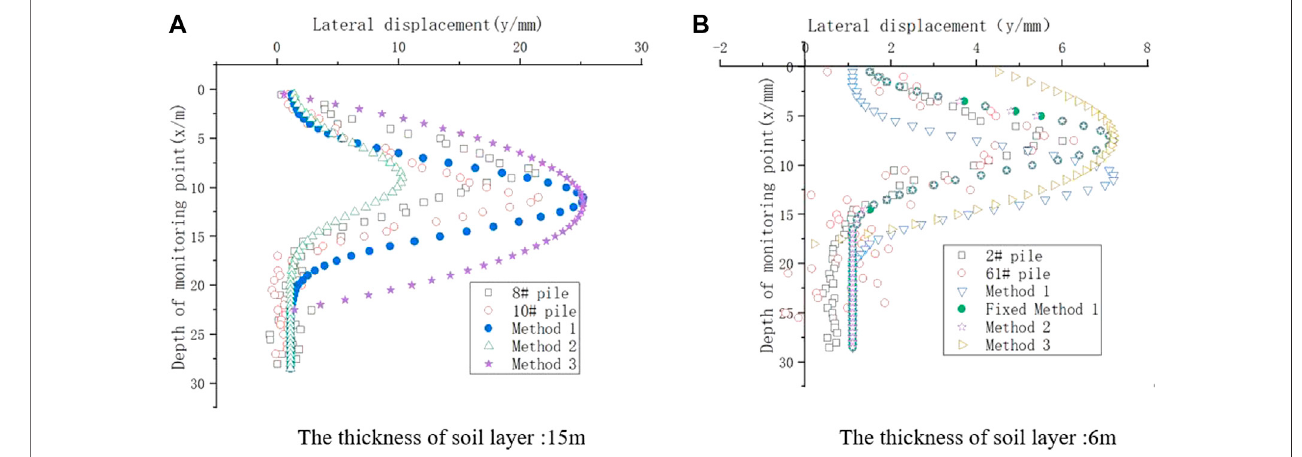
FIGURE 11 | Comparison of horizontal displacement fi tting curves of piles. (A) The thickness of soil layer :15 m. (B) The thickness of soil layer :6 m.